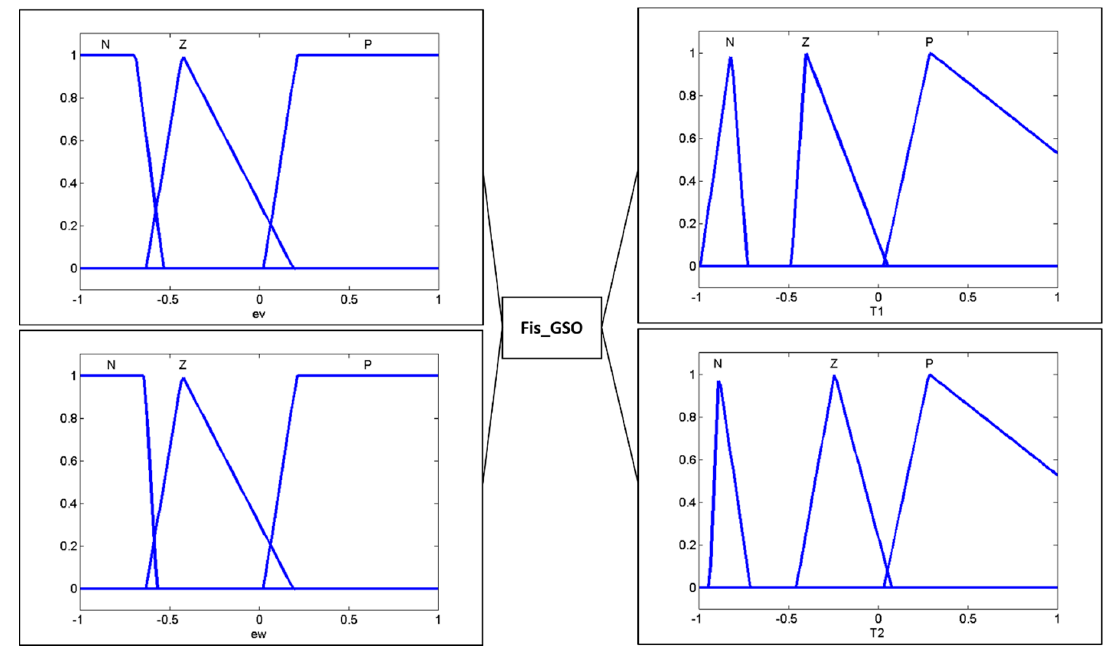
Figure 17. Fuzzy controller optimized with GSO.